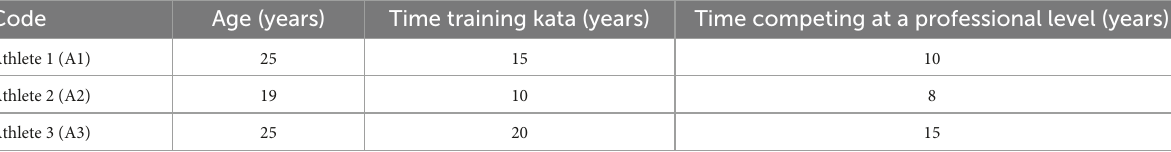
TABLE 1 Athletes’ description during the 2019 Pan American Games.